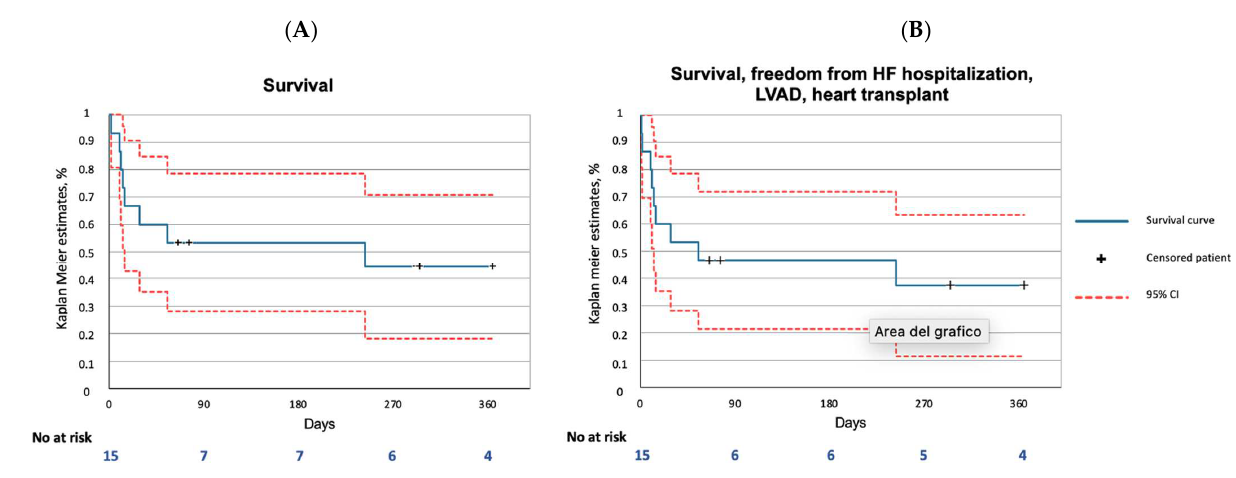
Figure 1. One-year outcomes in the Impella RP subanalysis of the IMP-IT registry. ( A ) Survival; ( B ) Composite of survival, freedom from HF hospitalization, LVAD and heart transplantation. HF, heart failure; LVAD, left ventricular assist device; CI, confidence interval.